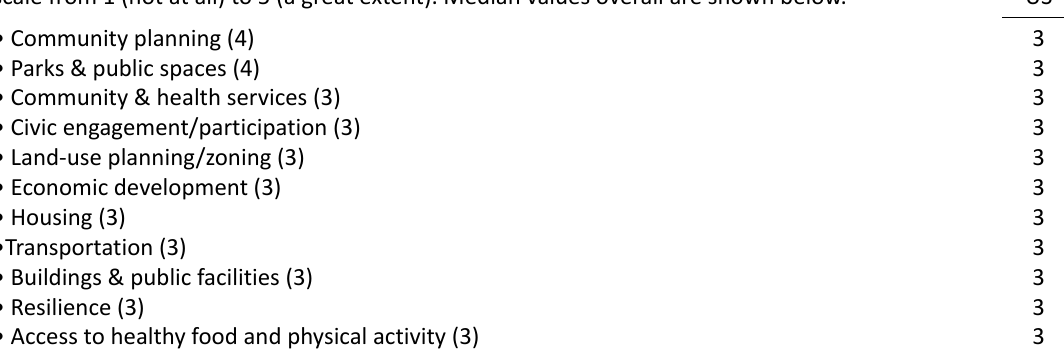
Table 1. Dependent variables. Source: International Planner Engagement Survey (AARP, 2017). LCA outcomes: The extent an all ages lens has been incorporated into your planning practice, scale from 1 (not at all) to 5 (a great extent). Median values overall are shown